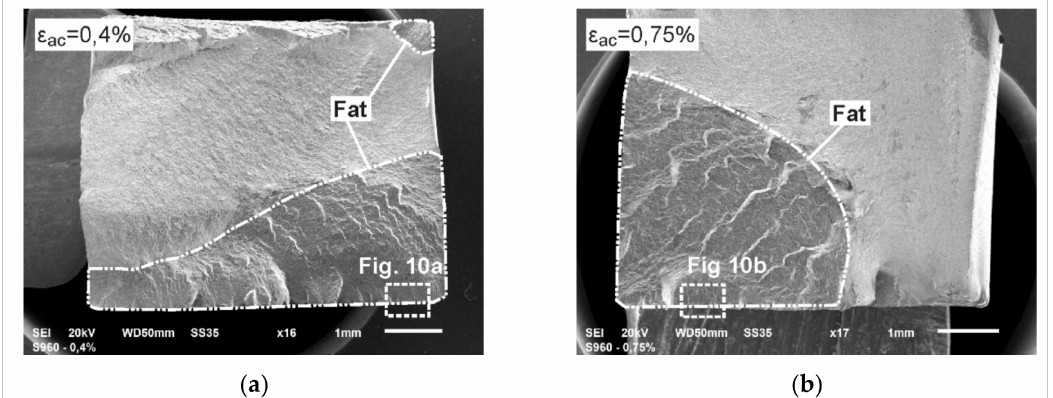
Figure 9. The fatigue fractures of PM tested at load ε ac : ( a ) 0.4%; ( b ) 0.75%.